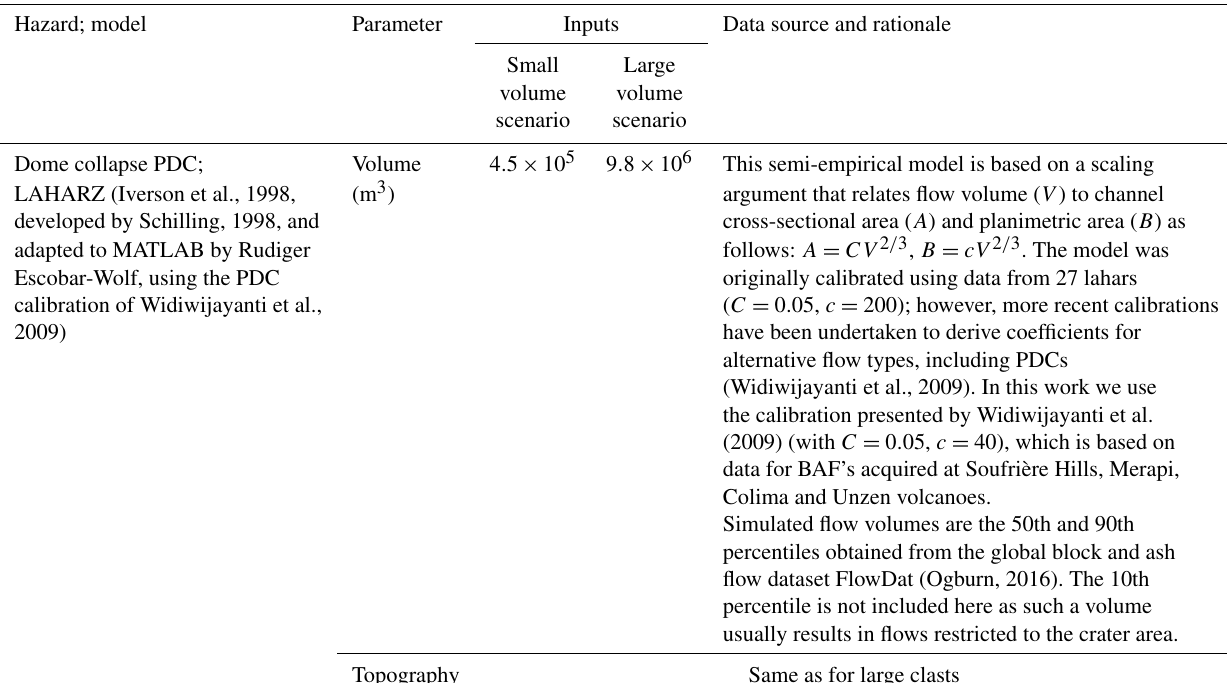
Table A3. Model input parameters and their rationale used for simulating dome collapse PDCs. Hazard;